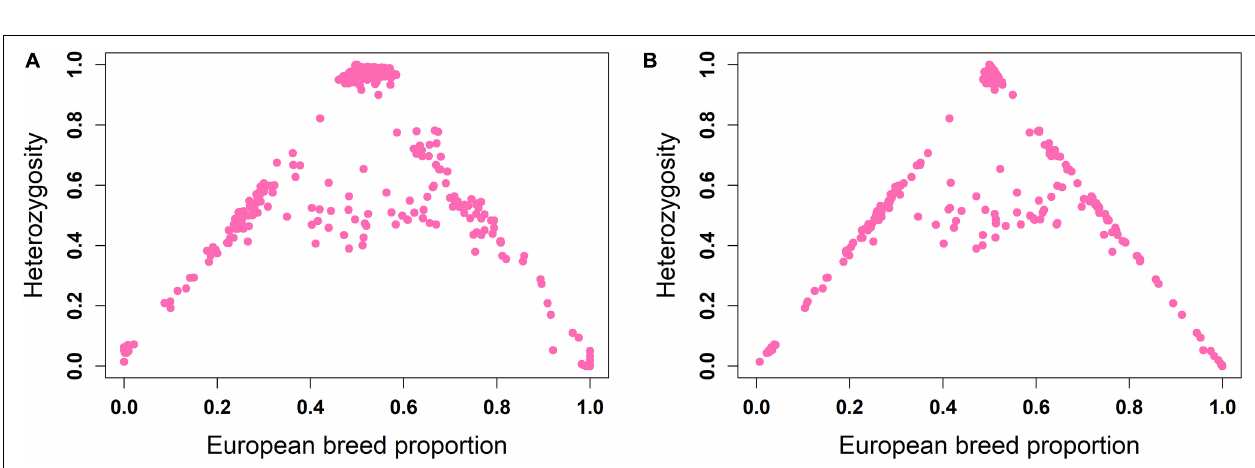
FIGURE 5 | Ancestral origin heterozygosity in West African crossbreds plotted against European breed proportion estimated from a three-way admixture using (A) ADMIXTURE and (B) LAMP-LD.